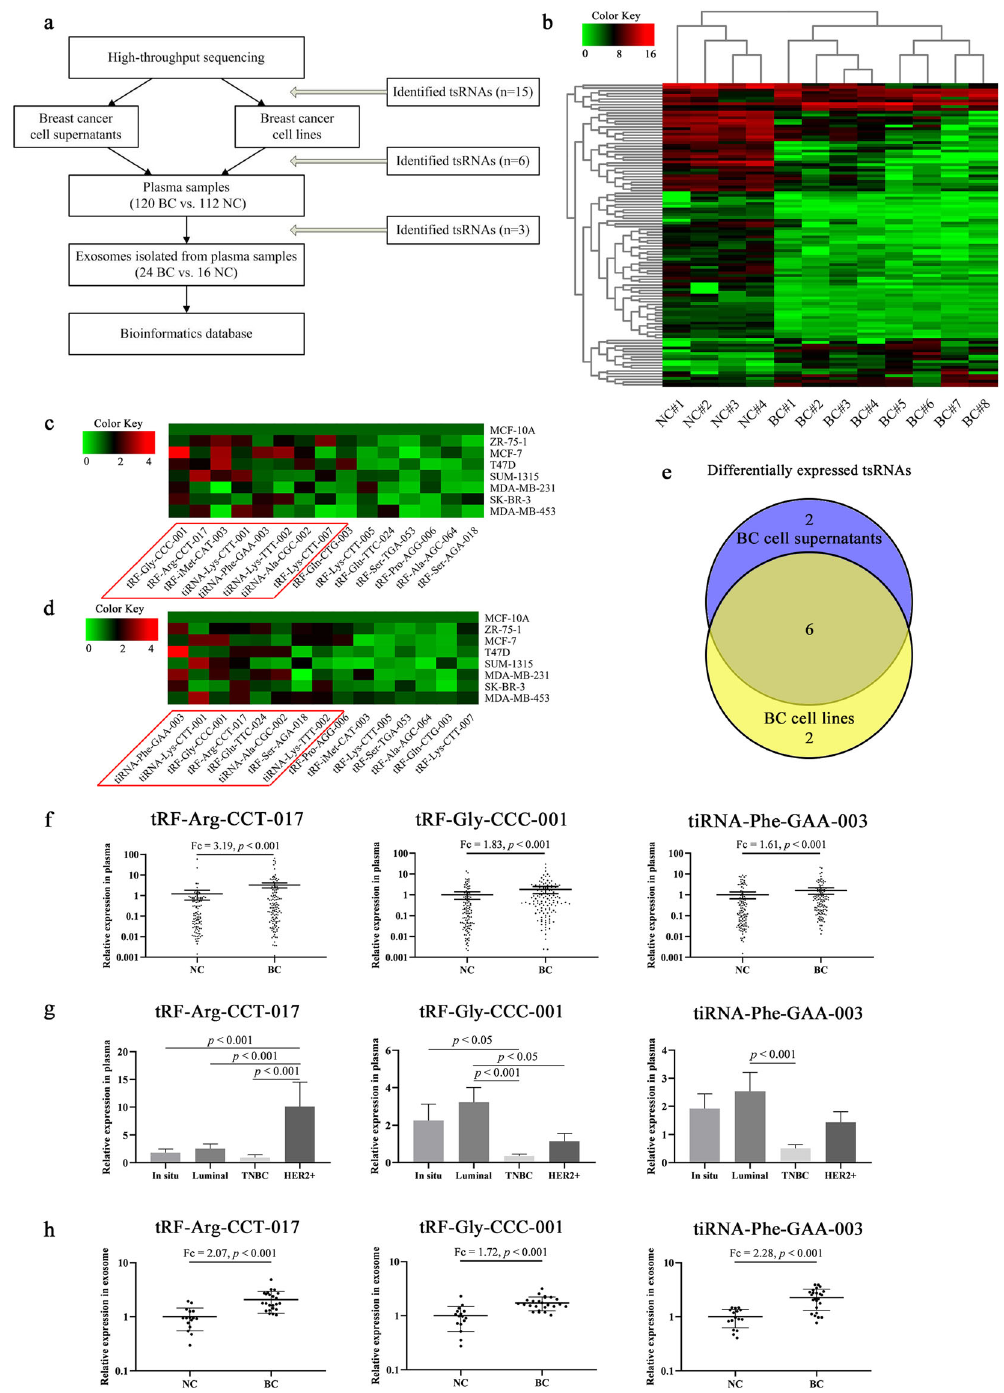
Fig. 1 Identi fi cation of differentially expressed tsRNAs in plasma. a Flowchart of study design. b Heatmap clustering analysis of differentially expressed tsRNAs between 8 patients with BC and 4 healthy controls by high-throughput sequencing. c Relative expression levels of 15 tsRNAs in cell supernatants by qRT-PCR. The red box represented the expression levels in at least 3 BC cell supernatants were higher than that in human breast epithelial cell MCF-10A (fold change >1.5, p < 0.05). The color key meant fold change. d Relative expression levels in cell lines by qRT-PCR. The red box represented the expression levels in at least 3 BC cell lines were higher than that in MCF-10A (fold change >1.5, p < 0.05). The color key meant fold change. e Comparison of the results in cell supernatants and cell lines, and 6 tsRNAs were identi fi ed. f Expression levels of tRF-Arg-CCT-017, tRF-Gly-CCC-001, and tiRNA-Phe-GAA-003 in plasma samples from 120 patients with BC and 112 healthy controls by qRT-PCR. g Expression levels in plasma samples of different subtypes. h Expression levels in exosomes isolated from plasma samples of 24 patients with BC and 16 healthy controls by qRT-PCR. Horizontal line means with SEM. Y axis represents the relative expression (2 − ΔΔ Ct ). NC healthy controls, BC patients with breast cancer.